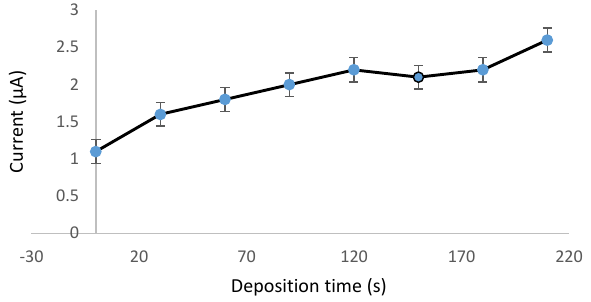
Figure 3. Effect of different deposition times applied to a 1.0ppm standard cadmium solution in an acetate buffer with a pH of